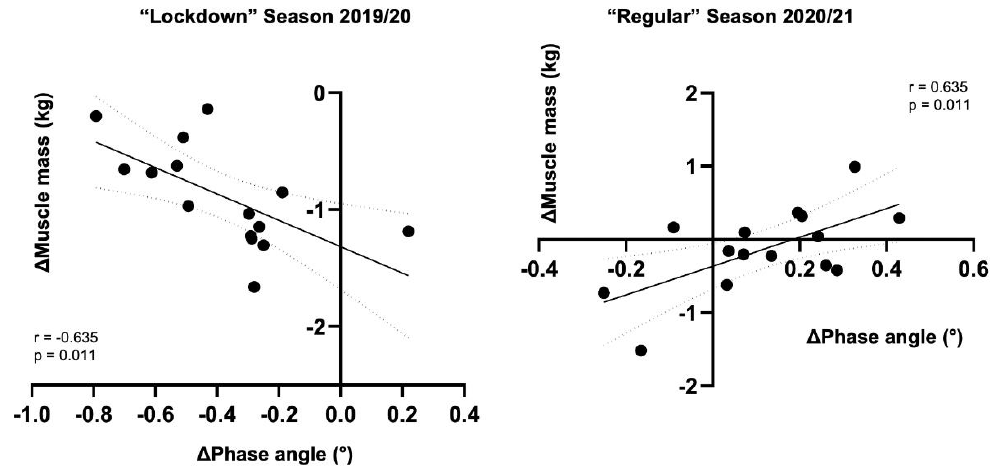
Figure 3. Scatterplots showing the associations between change in phase angle and change in muscle mass.